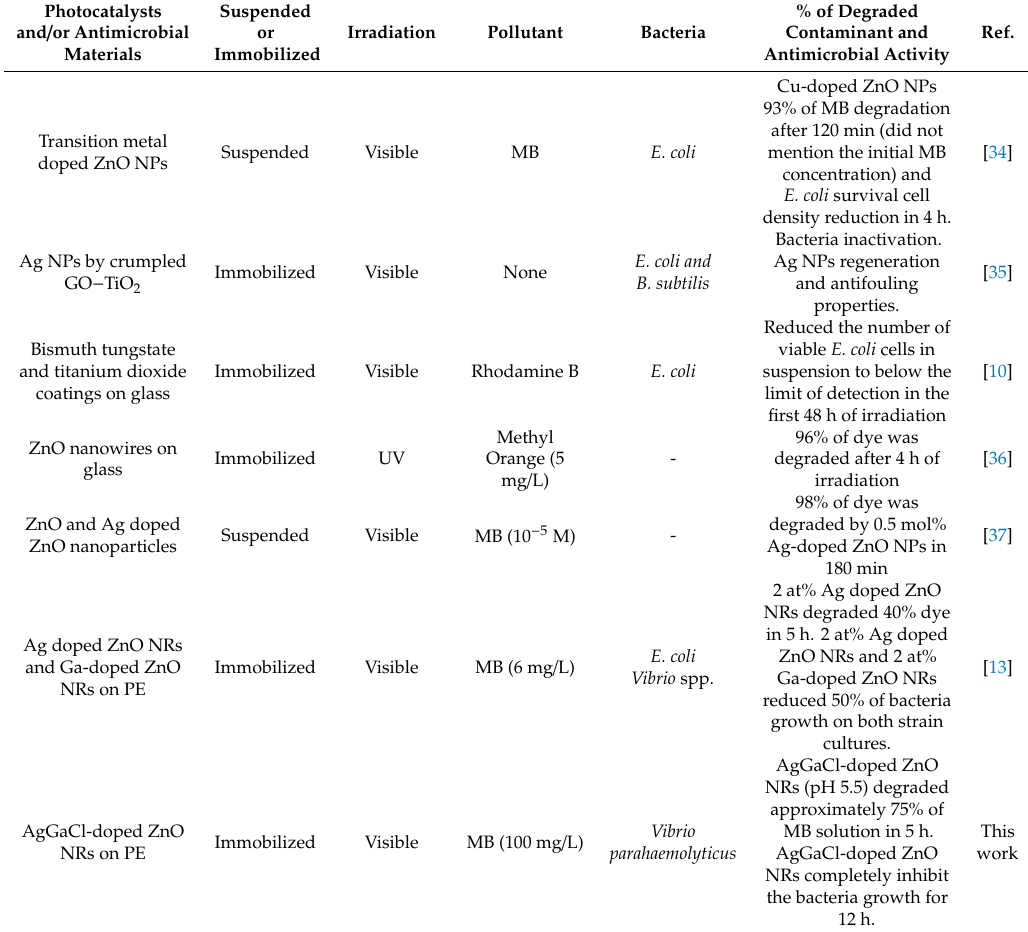
Table 1. Comparative results between other recent studies and the present study on the development of photocatalytic and / or antimicrobial materials for water